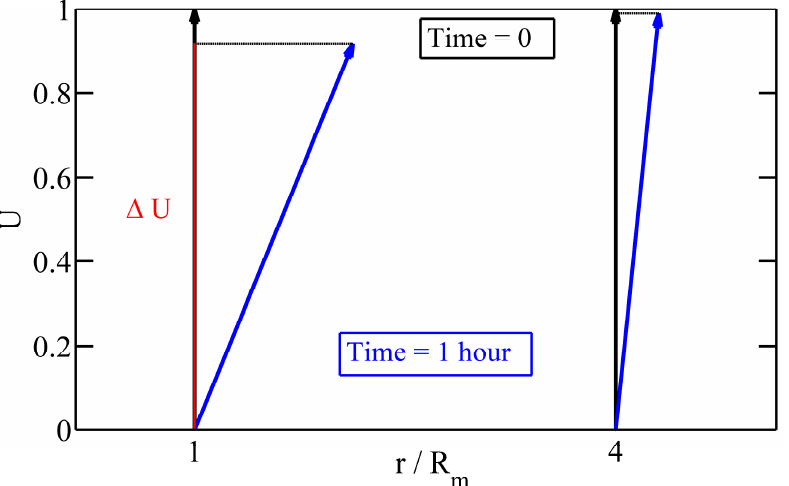
Figure 7. Schematic description of the temporal wind variations at different distances from the TC center.